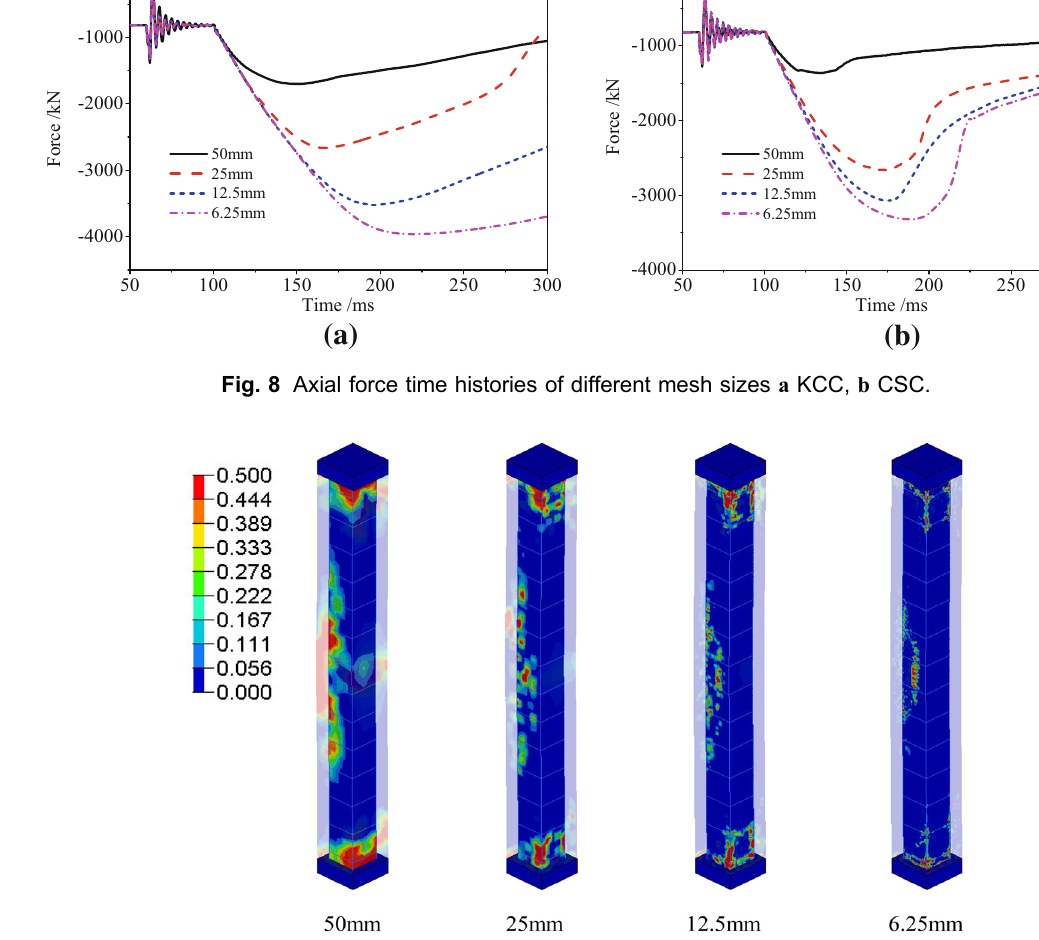
Fig. 9 Damage distribution of the RC column after blast loading (CSC